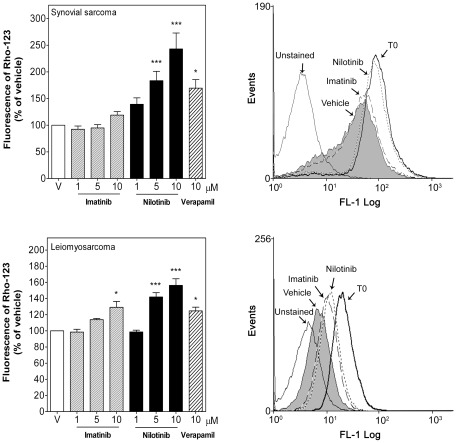
Nilotinib inhibited P-gp activity in human STS cells.Intracellular Rho-123 fluorescence (0.5 or 0.05 µM) was estimated by flow cytometry in synovial sarcoma SW982 cells after 2 h treatment or in leiomyosarcoma SK-UT-1 cells after 24 h treatment with vehicle (DMSO), imatinib (1–10 µM), nilotinib (1–10 µM) or verapamil (10 µM). Left, Median of intracellular Rho-123 fluorescence in the absence (vehicle, V) or presence of TK inhibitors normalized to vehicle-treated cells (taken as 100%). Each column represents mean ± SEM of five independent experiments. Right, Representative flow cytometry analysis of the intracellular Rho-123 fluorescence in the absence (vehicle) or presence of imatinib (10 µM) or nilotinib (10 µM) detected with excitation at 488 nm and emission at 580 nm. T0 was the intracellular Rho-123 fluorescence measured at t = 0. *
P<0.05 and ***
P<0.001 versus vehicle-treated cells.